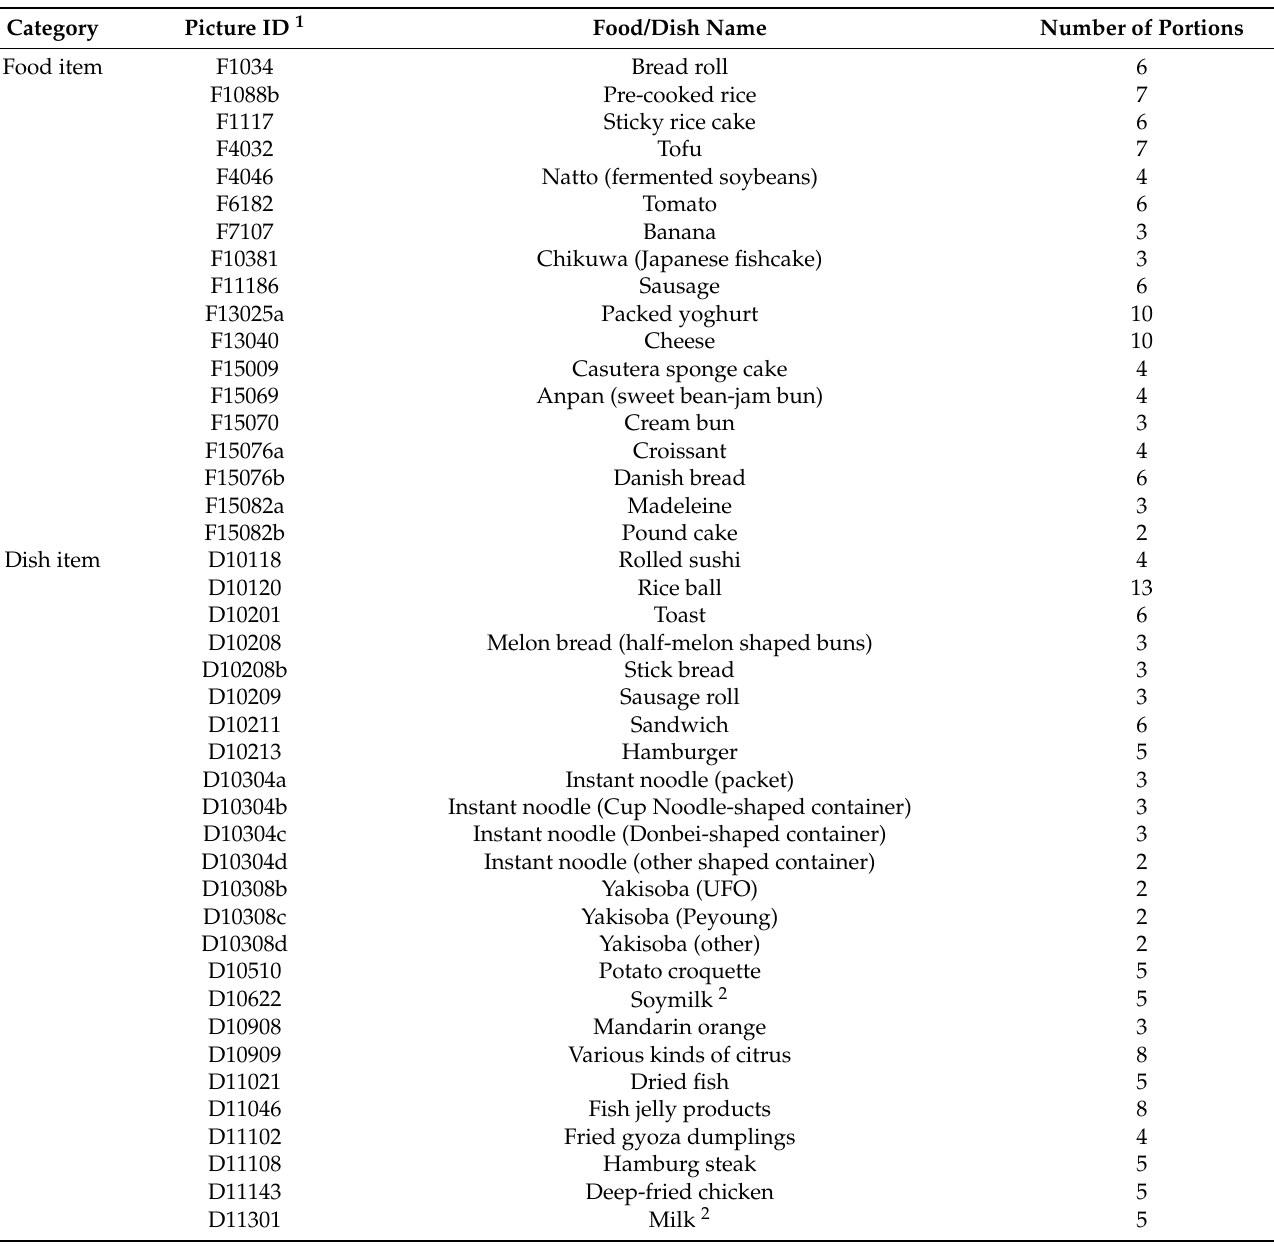
Table 2. List of items in the guide photographs ( n =